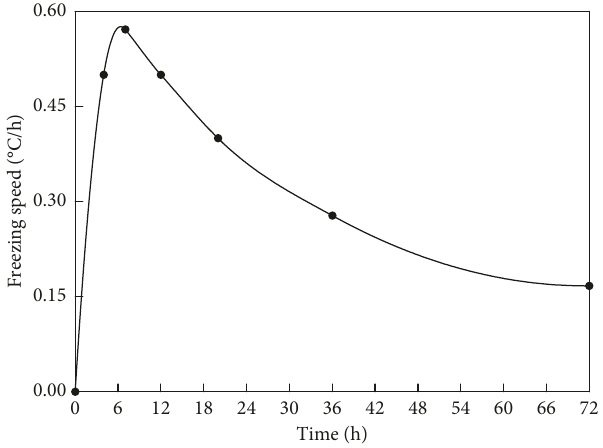
Figure 11: Variation of freezing speed with